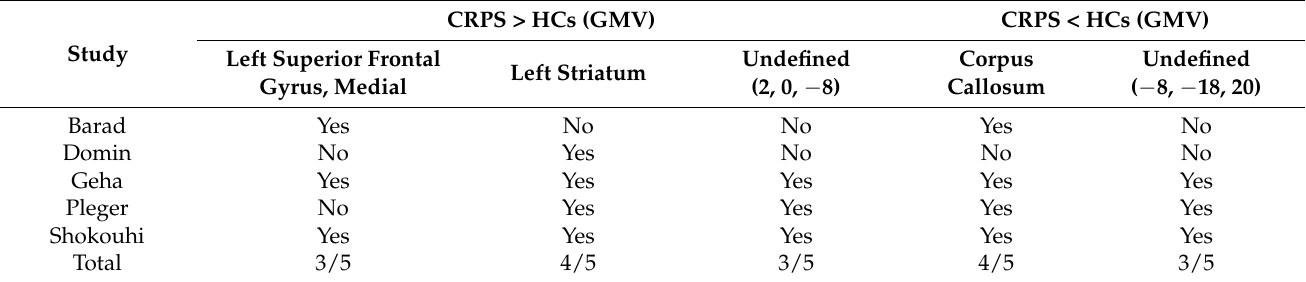
Table 4. Jackknife analysis of main analysis results.